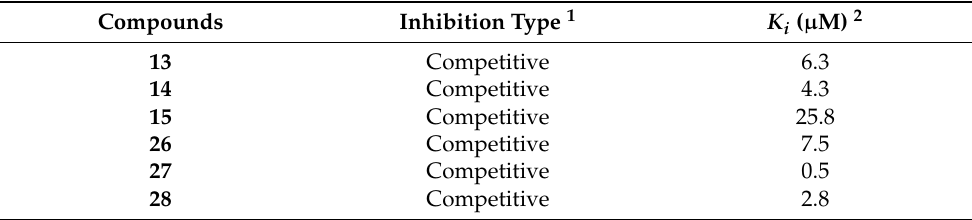
Figure 4. Lineweaver–Burk plots ( A , C , E ) and Dixon plots ( B , D , F ) for the β -glucuronidase inhibition of trimeric phloroglucinols 26 – 28 , respectively. Table 2. Kinetic parameters of active compounds against β -glucuronidase.